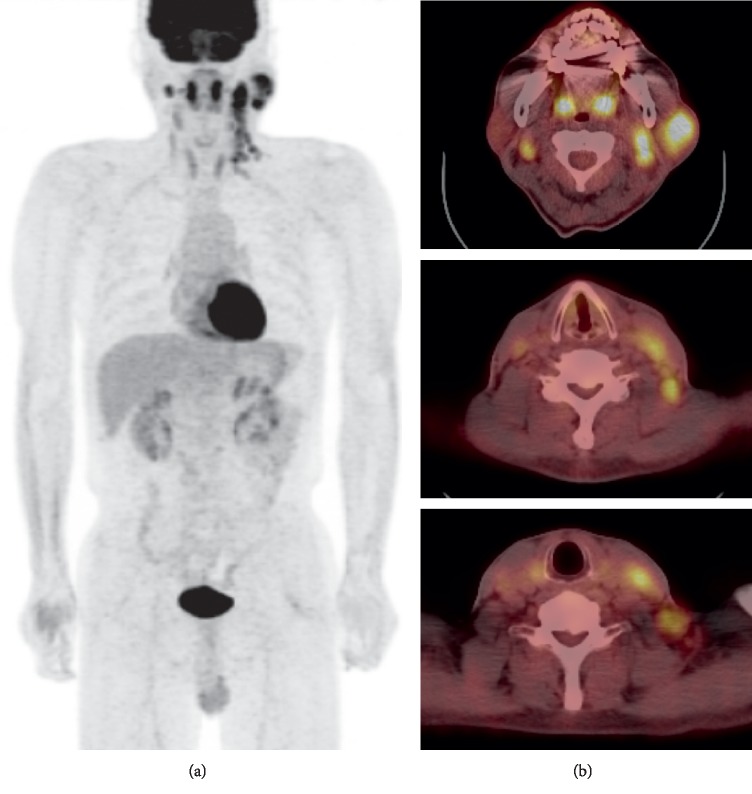
(a, b) There were intense F-18 fluoro-2-deoxyglucose- (FDG-) avid masses in the left parotid gland and multiple enlarged lymph nodes in both neck levels two to four and left neck level five, which are suggestive of left parotid gland malignancy with bilateral neck LN metastases on FDG positron emission tomography-CT (PET-CT).